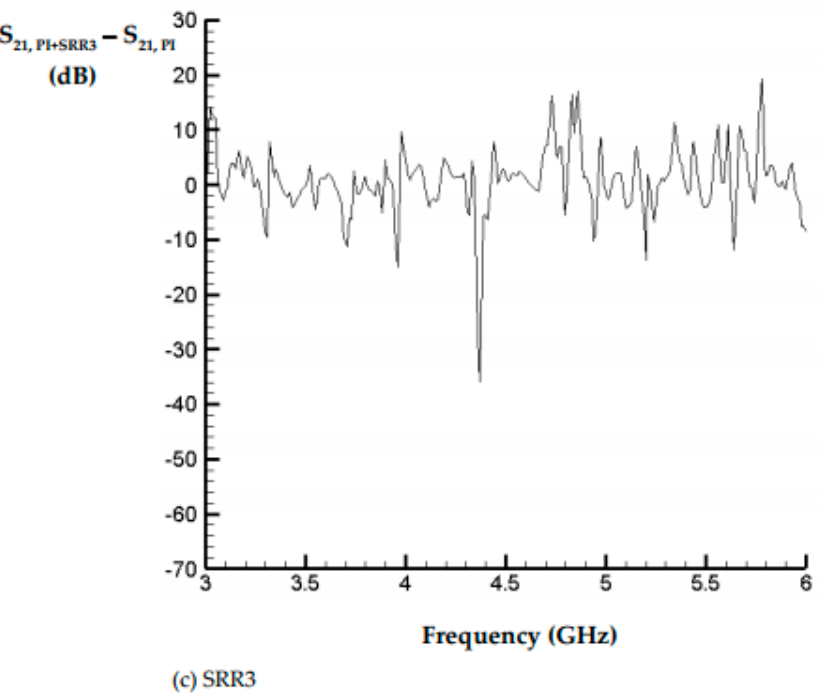
Figure 11. Difference between PI film with and without SRRs.